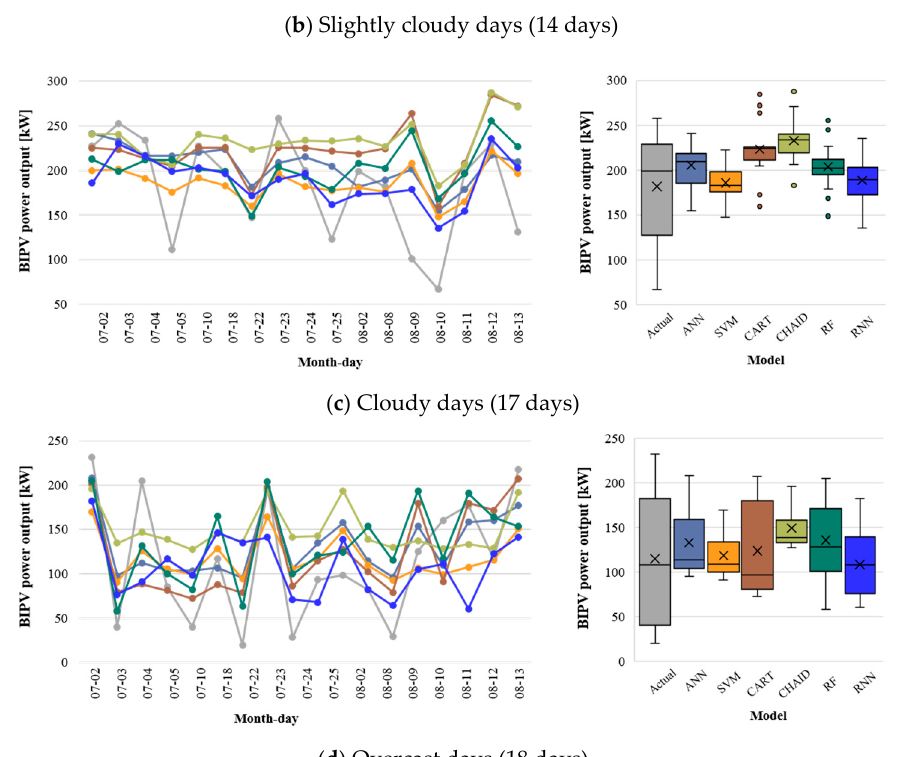
Figure 7. Prediction results of the daily total BIPV power output with typical sky conditions based on six machine-learning models.